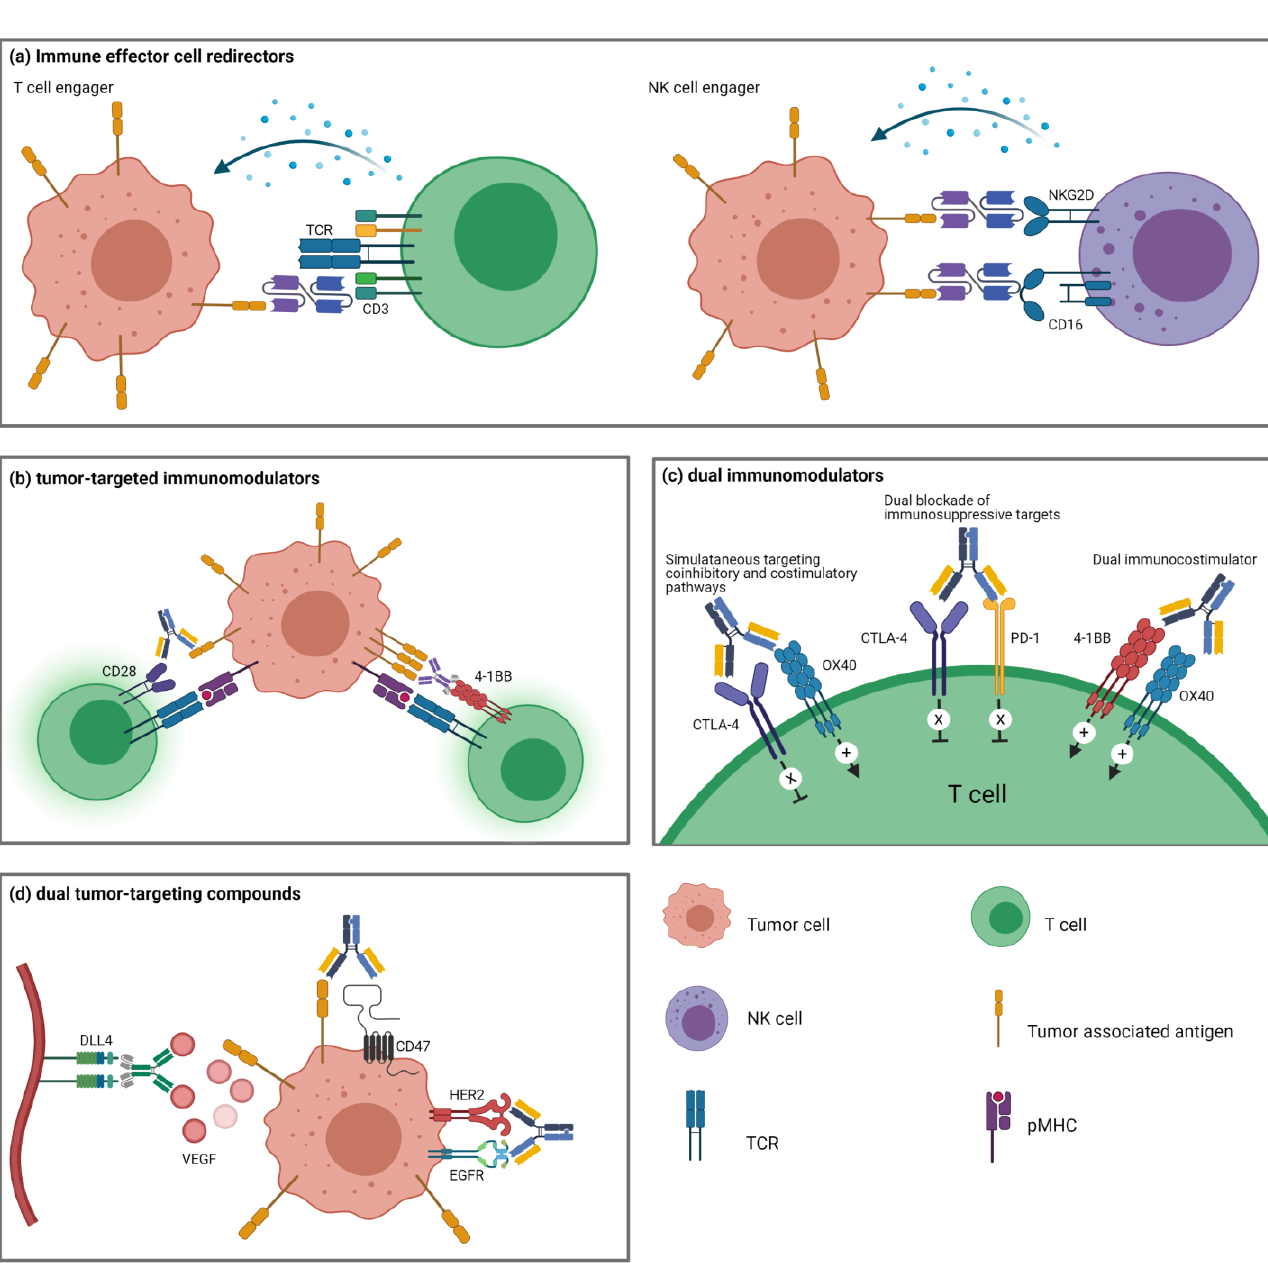
Figure 2. The types of bispecific therapeutics in immuno-oncology. Bispecific therapeutics are grouped into four